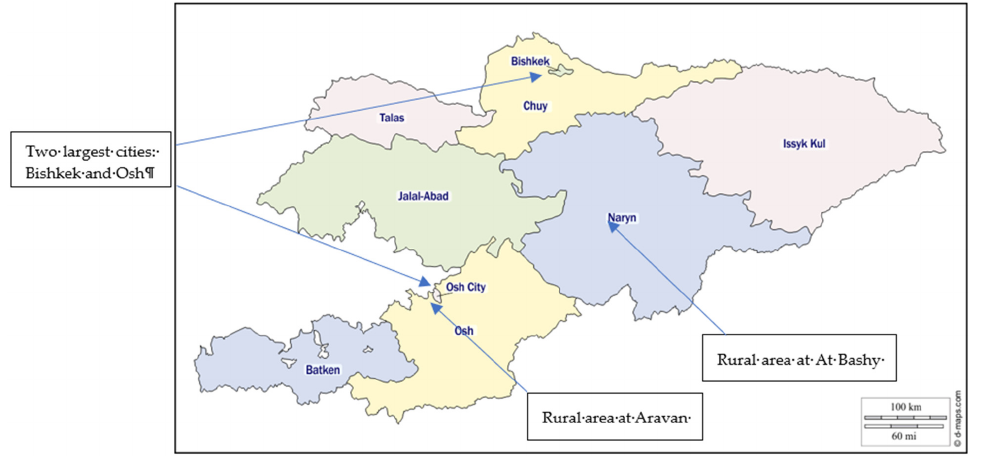
Figure 1. Map of Kyrgyzstan with an indication of field locations [51].